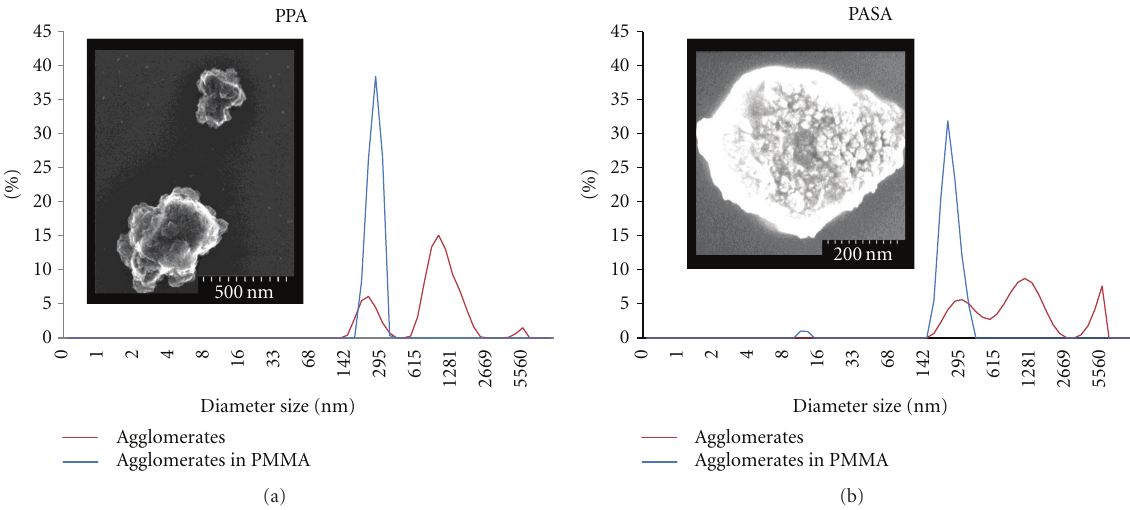
Figure 6: PA:Tb 3+ :LaF 3 (a) and ASA: Tb 3+ :LaF 3 (b) agglomerate diameters in water (red) and dispersed in PMMA/THF (blue) at 5:1 ligand to nanoparticle ratio. STEM images (inset) show representative agglomerates found in the polymer nanocomposite.